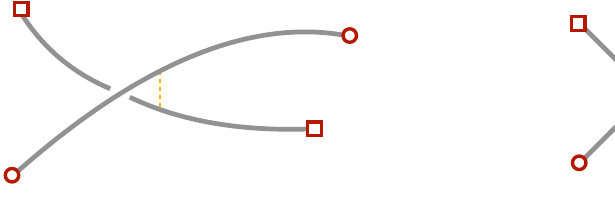
Figure 4 . On the left the recombined brane web after tachyon condensation. The (1 , 1) and (1 , − 1) 5-branes are separated in a direction transverse to the ( x, y ) plane. On the right the connected supersymmetry breaking configuration. Each three junction is supersymmetric but the whole system breaks supersymmetry since the boundary conditions of the D5-branes (horizontal line) on the two three-junctions are mutually